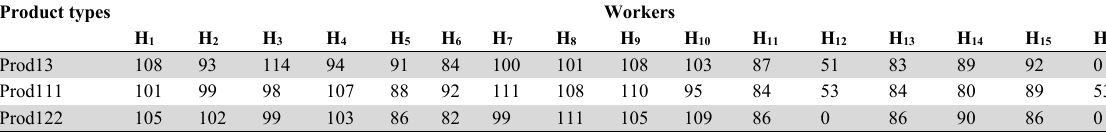
) [%] (cid:3043) , (cid:3035)